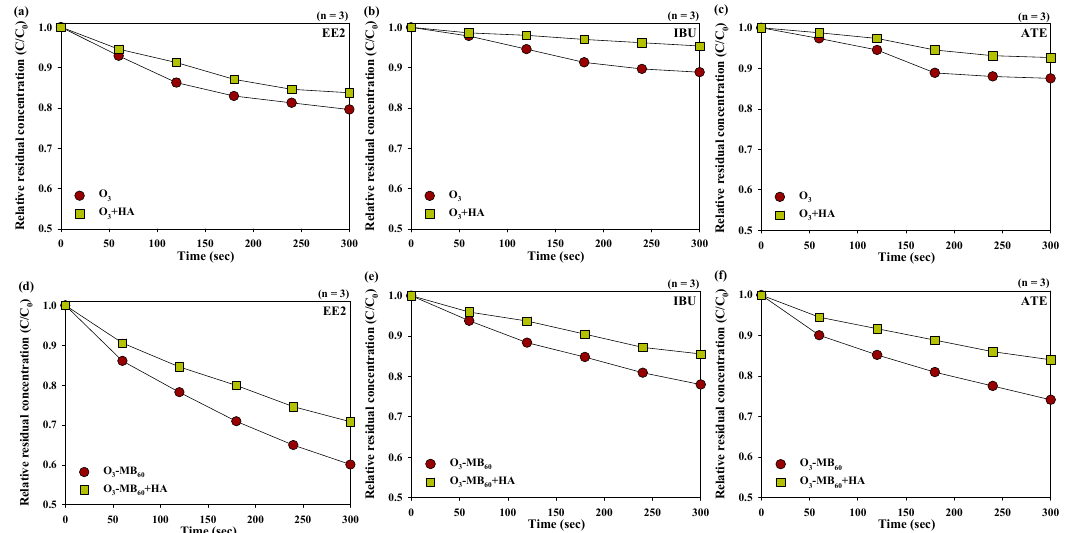
Figure 7. The effects of humic acids on the degradation of the pharmaceutical compounds during the ( a – c ) millibubble ozonation and ( d – f ) microbubble ozonation processes (the initial concentration of each pharmaceutical compound = 2.0 μ M; the concentration of humic acid = 5 mg/L; cavity pump frequency = 60 Hz; pH = 7.0; temperature = 20 °C ).